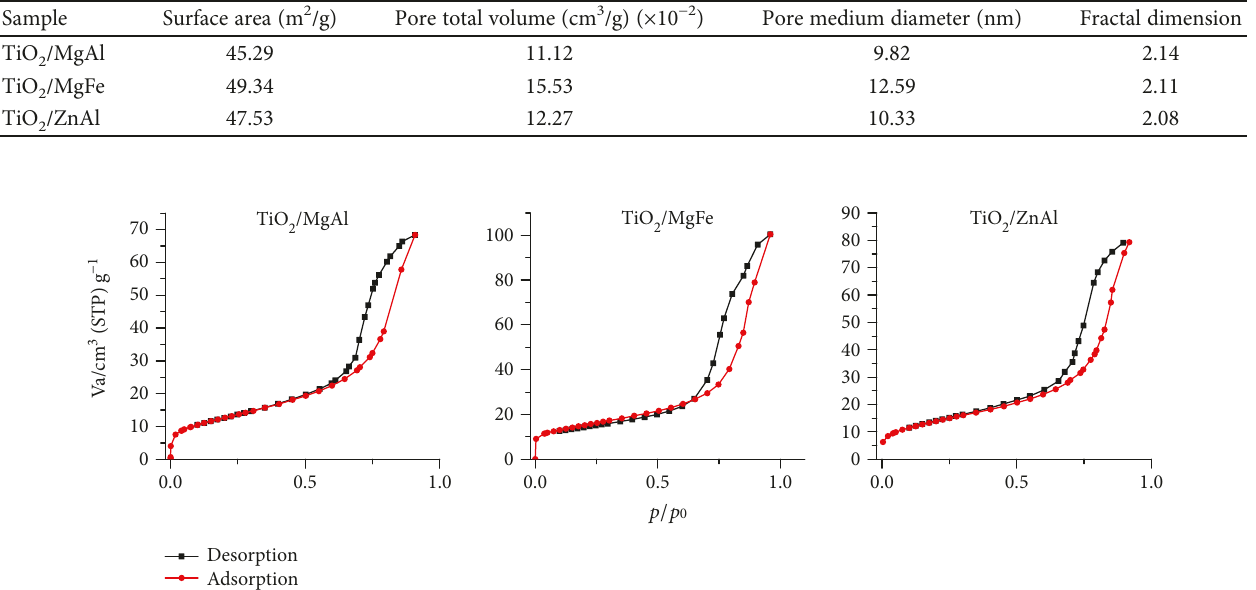
Figure 4: Adsorption-desorption N